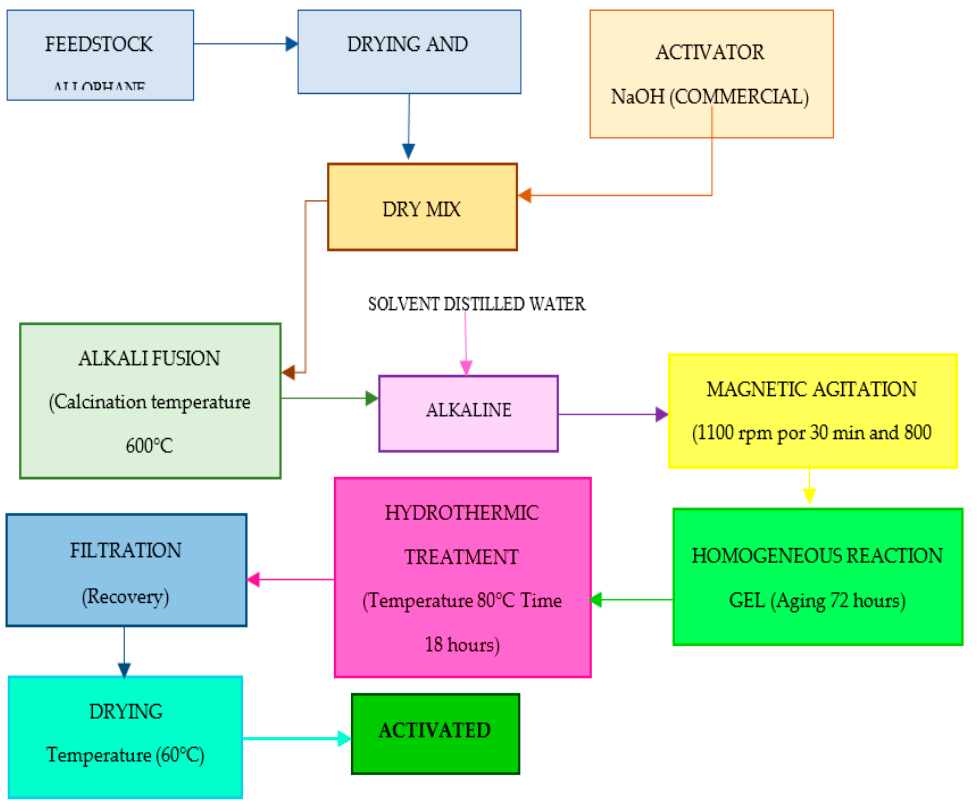
Figure 3. Flow Diagram of the Alkaline Fusion and Hydrothermal Treatment Procedure. Table 9. Fourier Transform Infrared Spectroscopy (FT-IR)